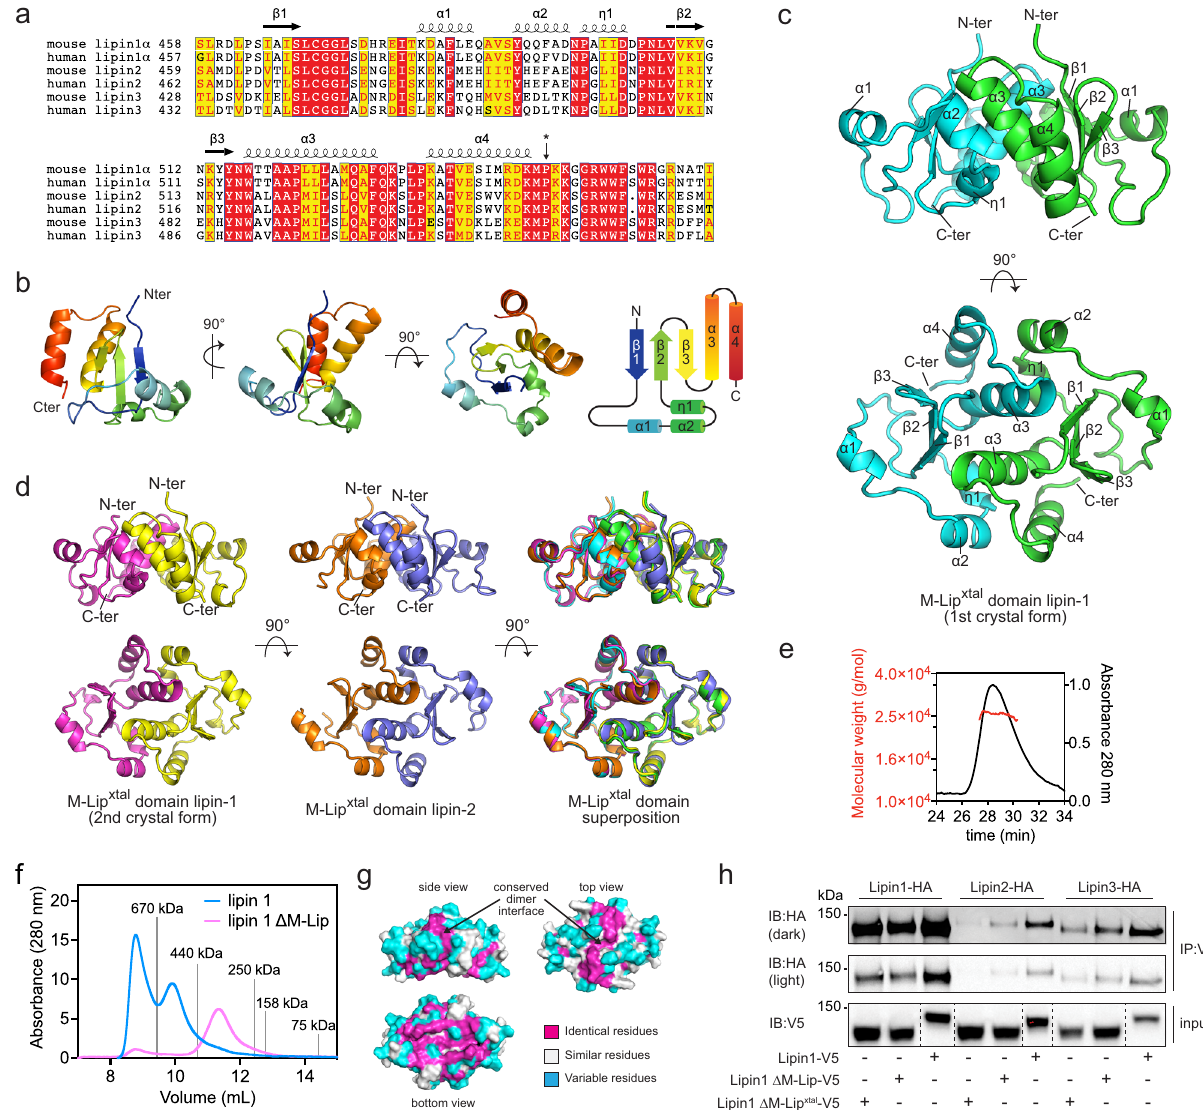
Fig. 2 The M-Lip domain is a new protein fold that dimerizes. a Sequence alignment of human and mouse lipin M-Lip domains with secondary structure elements above. The asterisk indicates the last residue of the M-Lip xtal domain. Red and yellow boxes indicate identical and positive homology residues. b Structure of a single subunit of the lipin 1 M-Lip xtal domain in three different views. The N- and C-termini are colored blue and red, respectively. c The M- Lip xtal domain forms a dimer with the α 3 helices mediating the majority of contacts at the dimer interface. Individual subunits are colored green and cyan. d Crystal structures and superimposition of the near identical lipin 1 and lipin 2 M-Lip xtal domains. e MALS data (left axis) with SEC traces (right axis) for the lipin 1 M-Lip xtal domain reports a MW of 25 kDa, consistent with a dimer (MW of 26 kDa). f SEC pro fi les of full-length and lipin 1 Δ M-Lip on SEC with gray lines indicating MW standards. Deletion of the M-Lip shifts the elution pro fi le to a smaller apparent MW. g Surface views of the lipin 1 M-Lip xtal domain showing conservation of the dimer interface. h Co-immunoprecipitation of HA-tagged lipins with V5-tagged lipin 1 constructs. Hepa1-6 cells were co-transfected with HA-tagged lipin 1, − 2, and − 3 and either V5-tagged lipin 1, Δ M-Lip, or Δ M-Lip xtal . Deletion of the Δ M-Lip or Δ M-Lip xtal domains reduced the amount of HA-tagged lipin proteins that co-immunoprecipitated. n = 1 independent experiment. Source data are provided as a Source data fi symmetric dimer in all three crystal forms with a root mean The structure of the M-Lip xtal domain revealed a protein fold square deviation for all atoms ranging between 0.36 – 0.77 Å with a three-stranded anti-parallel β -sheet at the core (Fig. 2b). (Fig. 2c, d). The observation of near identical dimers in three Flanking the β -sheet were a set of two alpha helices ( α 1 and α 2) different crystal structures strongly suggested the native qua- and a short 3 – 10 helix ( η 1) that were oriented perpendicular to ternary structure of the M-Lip domain as dimeric. To con fi rm the β -sheet and two C-terminal α -helices ( α 3 and α 4) that were this, we used size-exclusion chromatography coupled to multi- oriented parallel to the β -sheet. A Dali search 33 did not identify any similar existing protein structures. Thus, the M-Lip domain angle light scattering (SEC-MALS) to calculate the molecular represents a previously unrecognized and novel protein fold. weight (MW) of the M-Lip xtal domain in solution. SEC-MALS reported a MW of 25.6 ± 0.6 kDa for the mouse lipin 1 M- Lip xtal domain, which was consistent with the MW of 26 kDa The M-Lip domain forms a dimer . The M-Lip domain of for a M-Lip xtal dimer (Fig. 2e). mouse lipin 1 and lipin 2 formed a symmetric or near